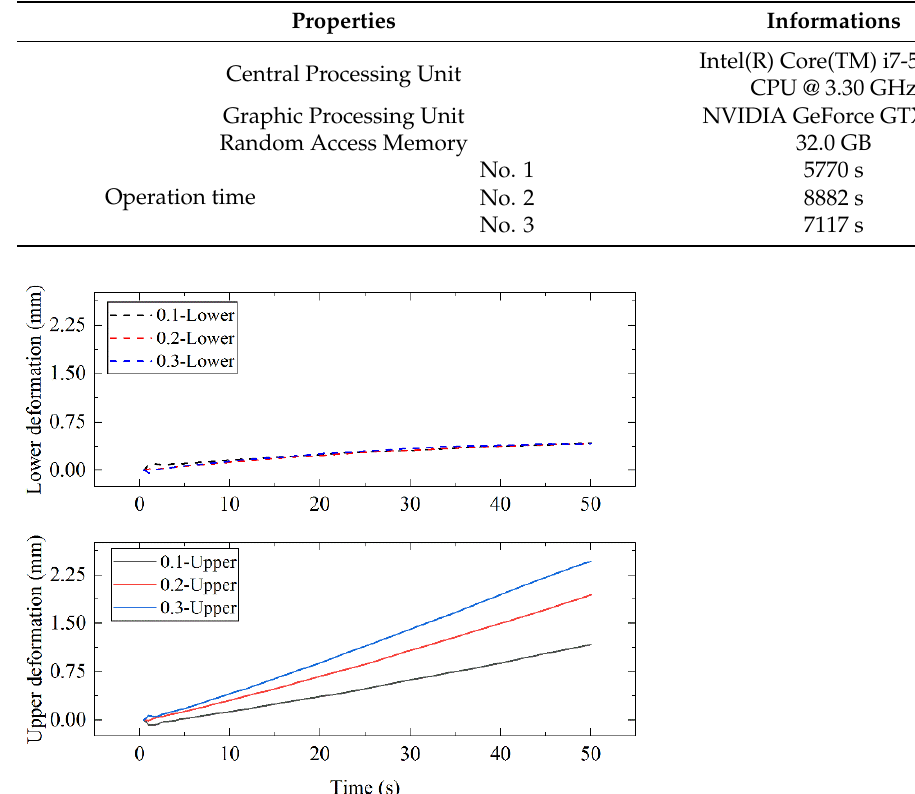
Table 6. Personal computer parameters and the simulation operation time.